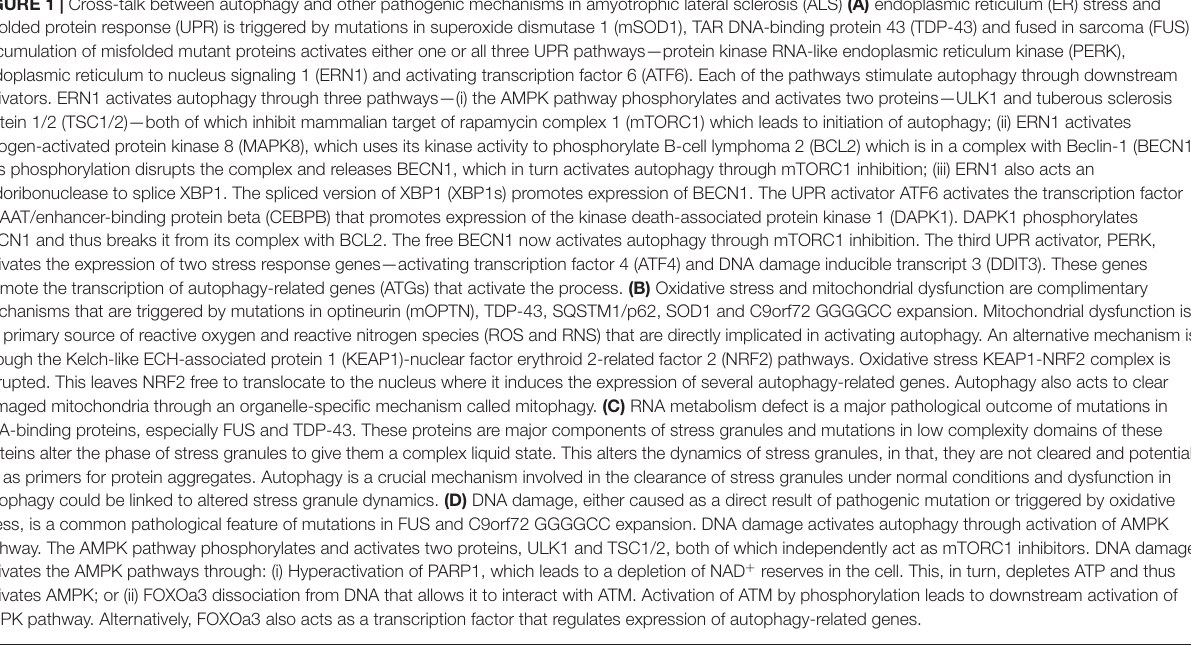
Frontiers in Molecular Neuroscience |